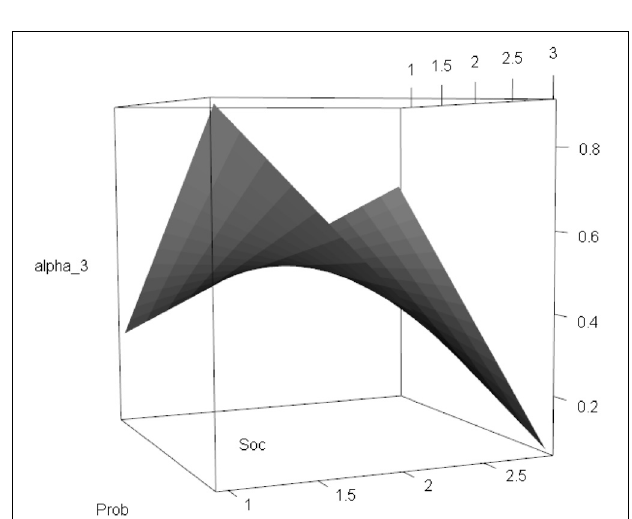
The gray crosses indicate the predicted slope with a predicted school-specific random intercept; the black line indicates the predicted Math score for the mean random intercept.